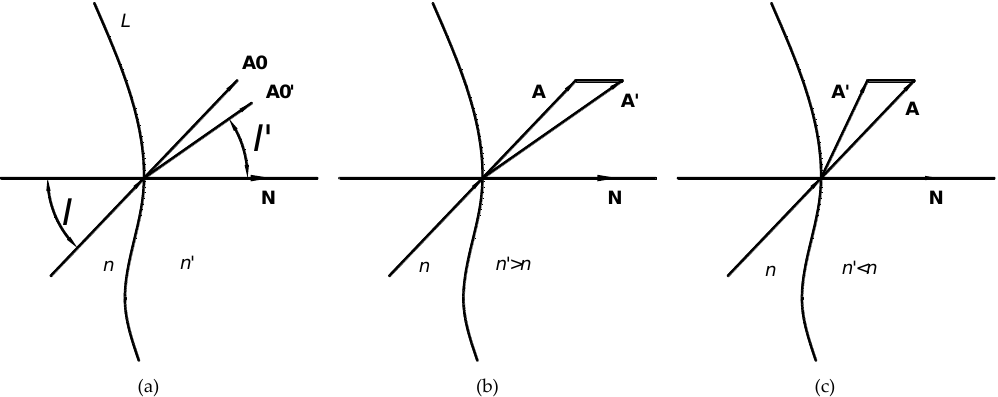
Figure 1. Schematic diagram of Snell’s law in vector form: ( a ) Snell’s law in vector form; ( b ) A'- A and N are forward parallel; ( c ) A'- A and N are antiparallel.